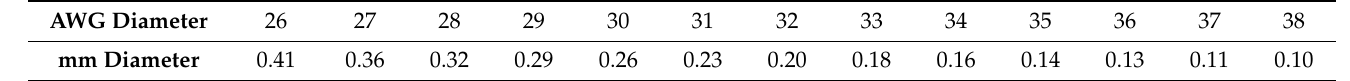
Table 4. Correspondence between the diameter in AWG and in